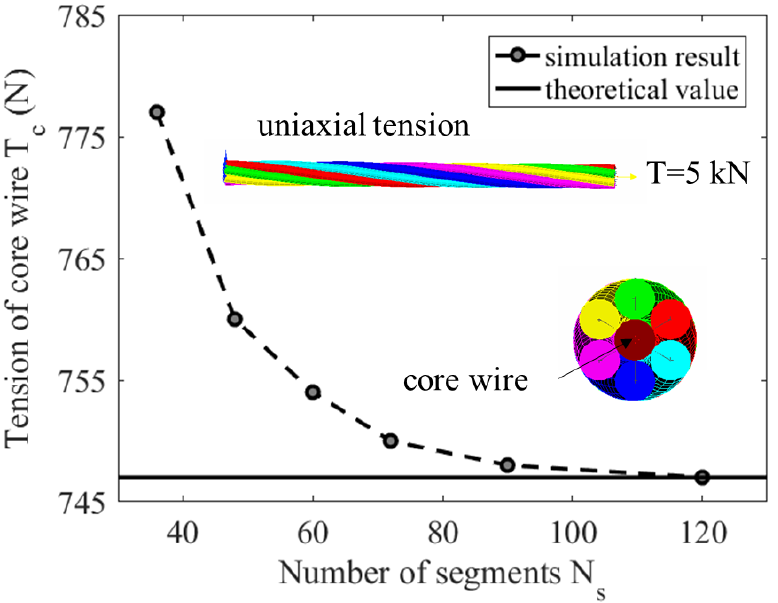
Figure 4. Convergence analysis for beam model: Tc − Ns for uniaxial tension at T = 5 kN.